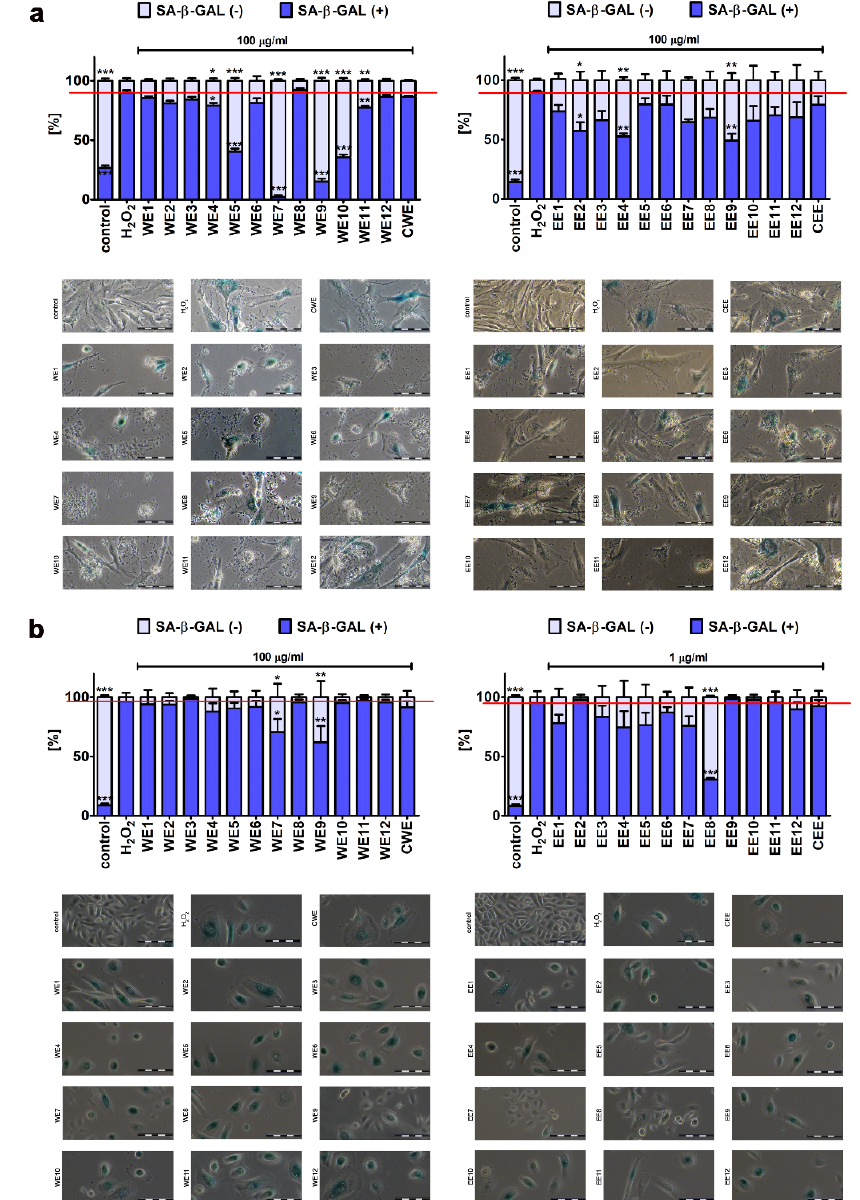
Figure 9. Extract-mediated changes in the levels of hydrogen peroxide-induced senescent BJ cells (( a ), 100 µ g / mL water extracts and 100 µ g / mL ethanolic extracts) and HEK cells (( b ), 100 µ g / mL water extracts and 1 µ g / mL ethanolic extracts). The e ff ects of water extracts (WE, twelve modified clones from WE1 to WE12) and ethanolic extracts (EE, twelve modified clones from EE1 to EE12) are shown. Control clone water extract is denoted as CWE and control clone ethanolic extract is denoted as CEE. Senescence-associated β -galactosidase activity. Representative microphotographs are shown. Scale bars 100 µ m, objective 20x. To emphasize extract action, a red horizontal line is added. Bars indicate SD, n = 3, *** p < 0.001, ** p < 0.01, * p < 0.05 compared to hydrogen peroxide treatment (ANOVA and Dunnett’s a posteriori test).